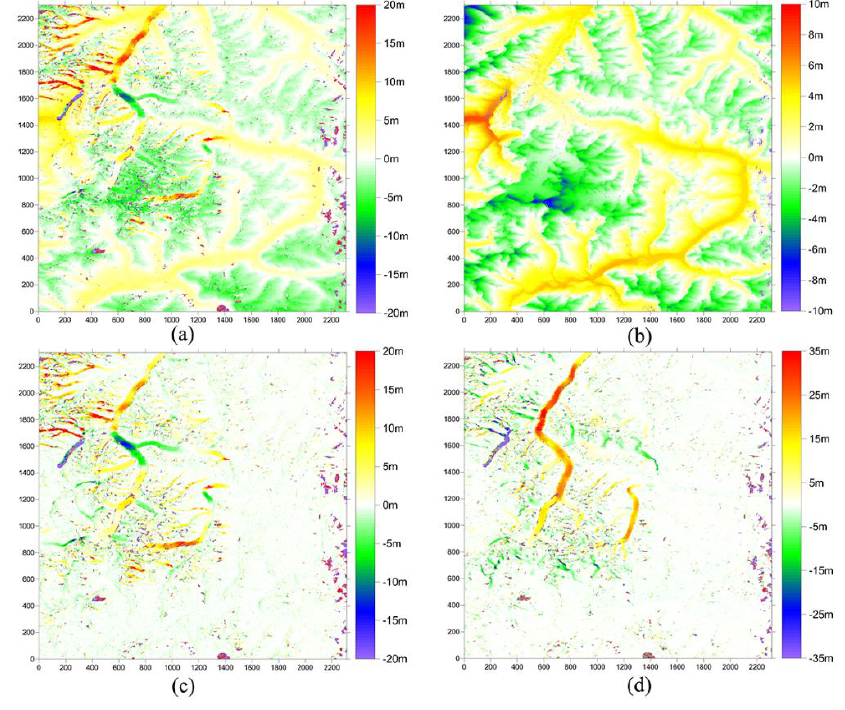
Figure 2. Glacier surface motion field of the study area. ( a ) Displacement field in the slant-range direction with topographic effect. ( b ) Contribution of the complex terrain of the study area in the slant-range direction. ( c ) Last displacement field in the slant-range direction without topographic effect or residual orbit error. ( d ) Displacement field in the azimuth direction without residual orbital